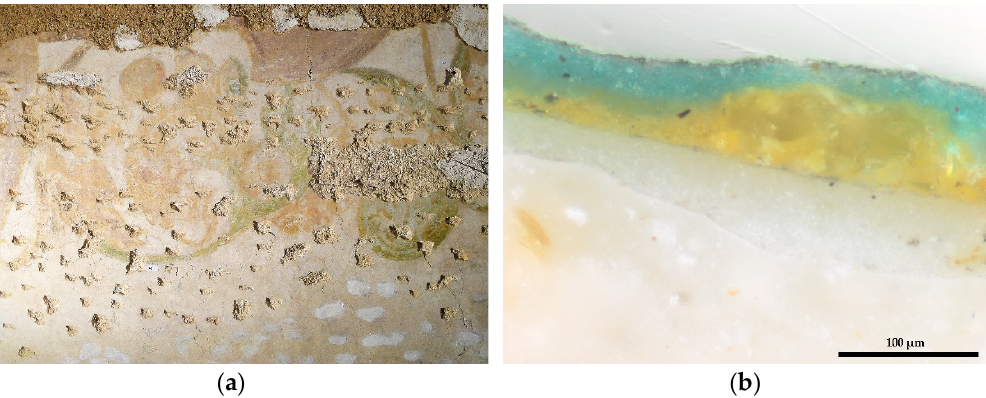
Figure 2. ( a ) Photo of the area where samples G4 and G5 were collected; ( b ) cross-section of sample G4 with a bluish-green copper pigment layer on top of the sample, magnification ×200.